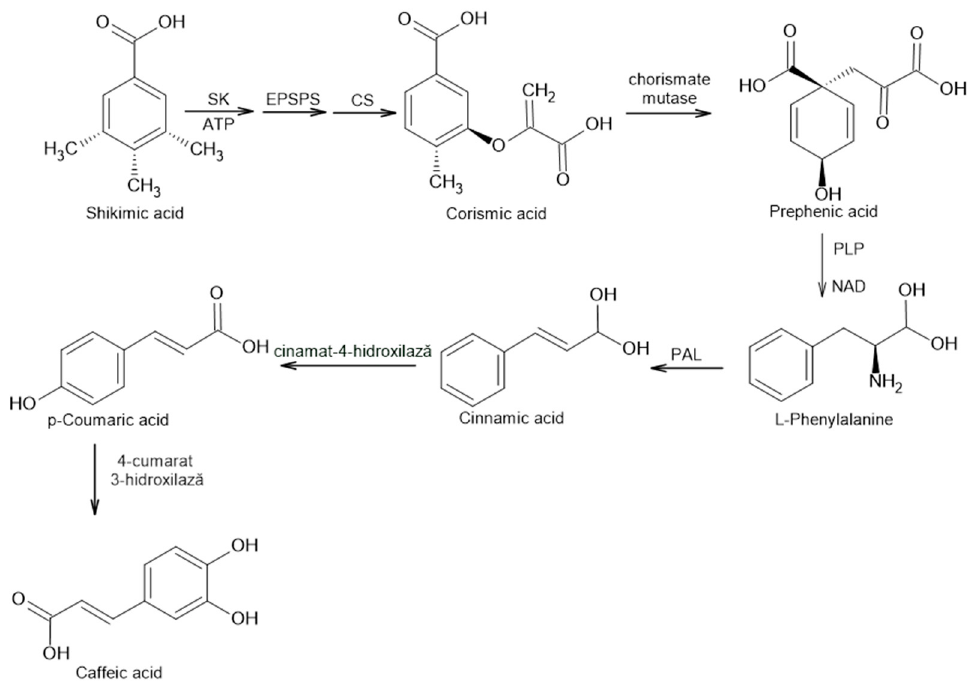
Figure 1. The biosynthesis of CA (figure made by using ChemDraw—http://www.perkinelmer.com/category/chemdraw) [20].